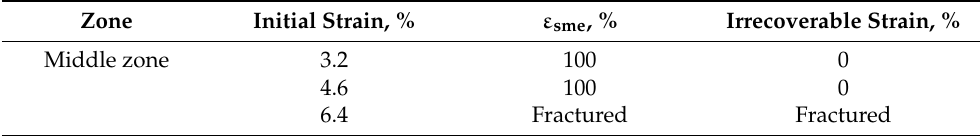
Table 4. The results of the bending tests during the investigation of the shape-memory effect for the middle zone of the heat-treated specimen,